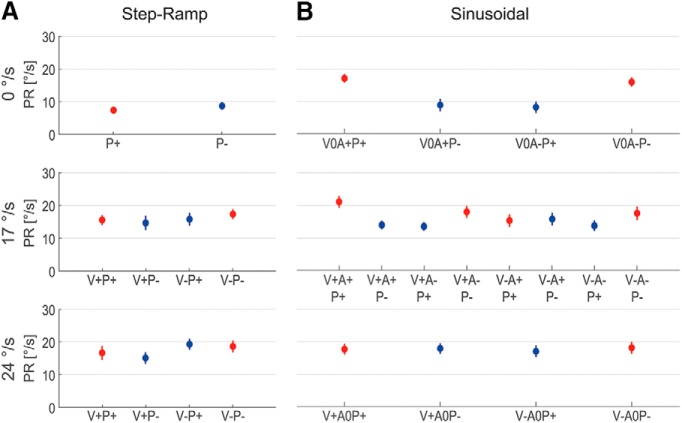
A, B, PR during step-ramp (A) and sinusoidal pursuit (B). Conditions are labeled according to the initial perturbation direction (P+, rightward; P−, leftward) and the directions of carrier velocity (V+, rightward; V−, leftward) and acceleration (A+, rightward; A−, leftward). Sinusoidal 0 and 24°/s conditions correspond to the turning points and the center points of the carrier movement, respectively. Peak-first (A) and ipsidirectional (B) perturbations are colored red, and peak-last and contradirectional perturbations are colored blue. Vertical lines mark SEs. Note the difference between ipsidirectional and contradirectional PRs in the sinusoidal 0 and 17°/s conditions.